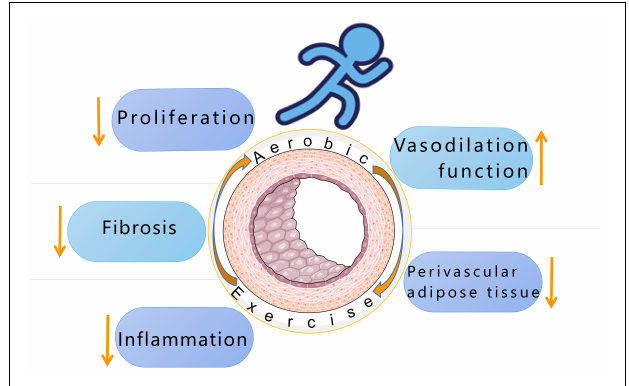
FIGURE 3 | Aerobic exercise improves hypertension by reducing inflammation, reducing fibrosis and proliferation, mediating vasodilation, and reducing perivascular adipose